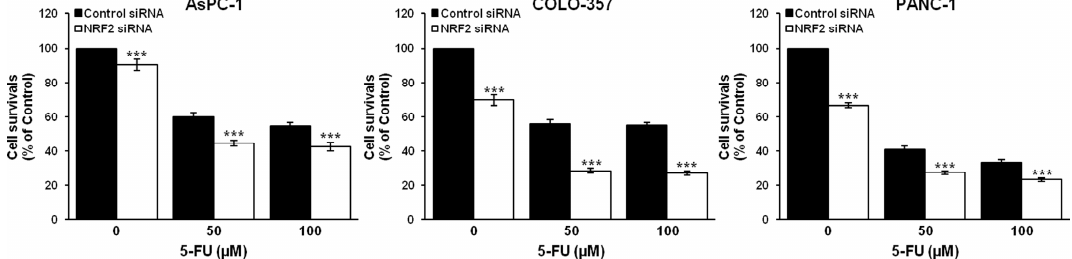
Figure 5. NRF2 knockdown sensitizes pancreatic cancer cells AsPC-1, COLO-357 and PANC-1 to chemotherapeutic agent 5-FU. AsPC-1, COLO-357 and PANC-1 cells were transfected with NRF2-siRNA or control-siRNA for 48 h and further treated with 5-FU at different concentrations (0, 50 and 100 µM) for 72 h. They were then subjected to cell viability assay using MTT. Error bars represent standard deviation. *** p < 0.001 represents the significant difference between NRF2 siRNA plus 5-FU group (filled bar) and control siRNA plus 5-FU group (open bar).